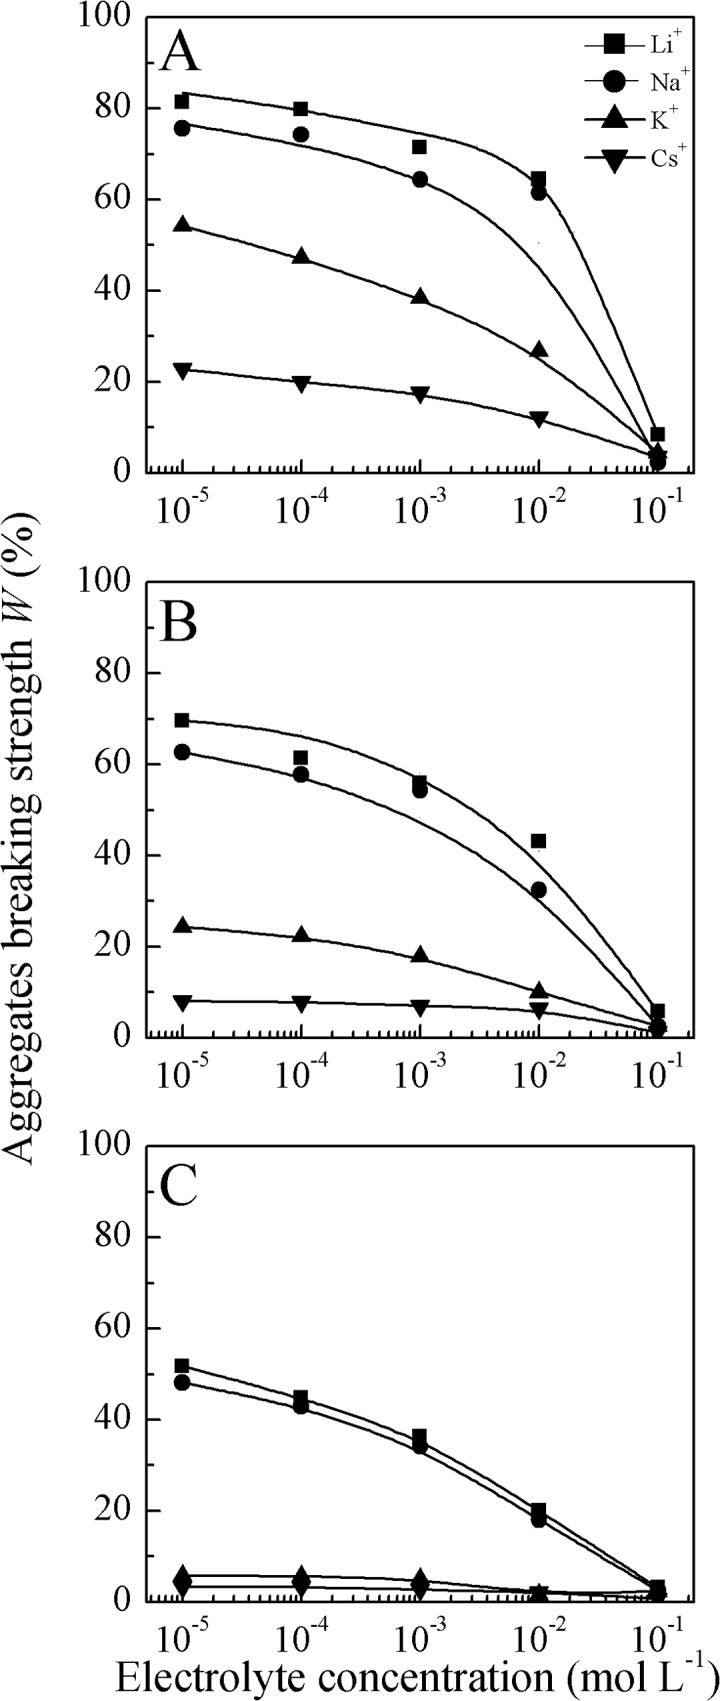
Relationship between aggregates breaking strength and electrolyte concentrations (A, B and C represent released small particles of d<10, 5 and 2 μm, respectively).